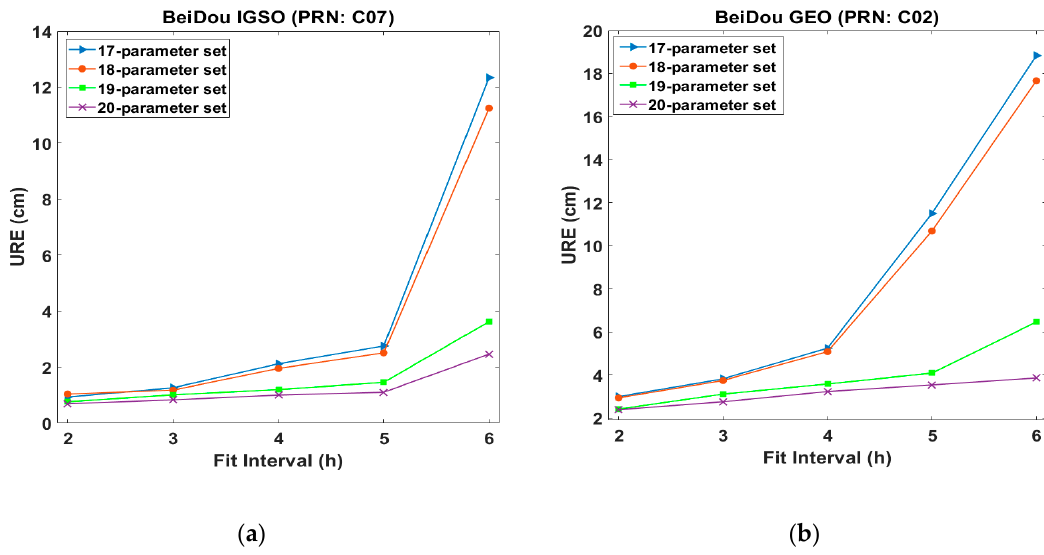
Figure 3. UREs vs. fit intervals: ( a ) BeiDou IGSO (PRN: C07); ( b ) BeiDou GEO (PRN C02).